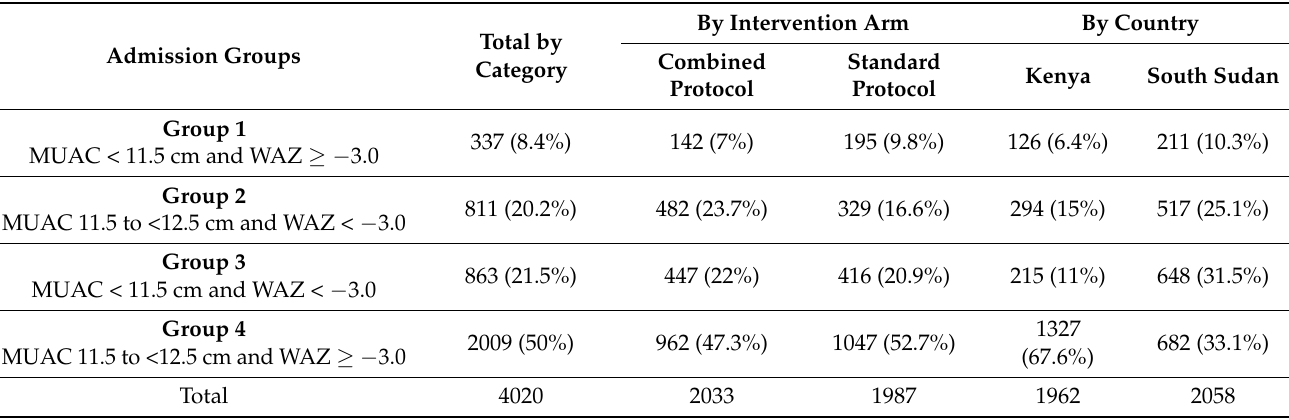
Table 2. Numbers of children by category at admission .